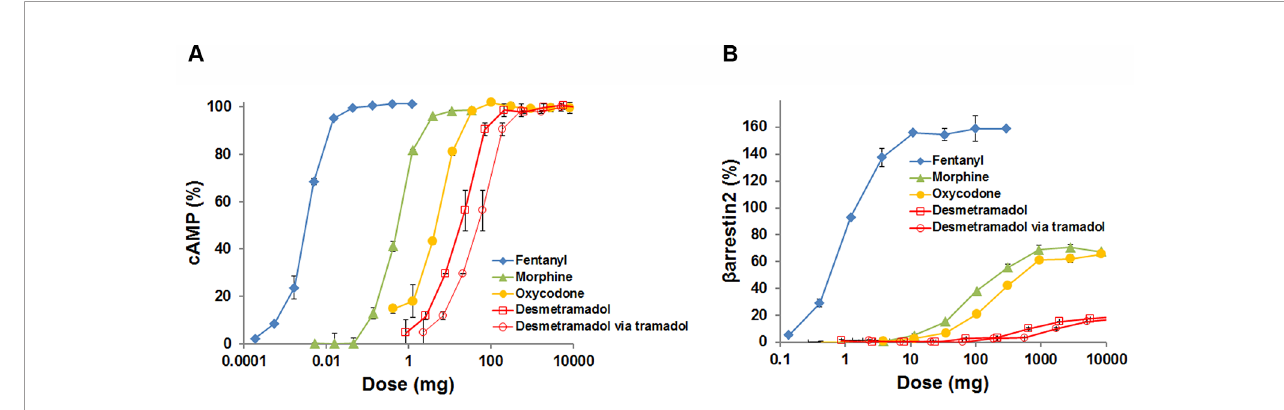
FIGURE 2 | G-protein modulated cAMP and b arrestin2 recruitment by the human MOR as a function of human dose. The adult human dose-to-maximum blood concentration (C max ) relationship for each opioid was used to model maximum cAMP accumulation and b arrestin2 recruitment as a function of human dose, where Dose = Reference Dose x (C tested /C max ) and the Reference Dose (mg) and C max (µM) are from Supplementary Table 1 and C tested (µM) is the tested agonist concentration. Data are means ± SD, displayed as percent of maximum [Met]-enkephalin ef fi cacy for assays run in duplicate. Data for doses >10 grams and > E max were censored for clinical irrelevance and to permit visualization of each curve, respectively. (A) Percent cAMP versus dose. (B) Percent b arrestin2 recruitment versus dose. Data for desmetramadol are shown for both direct dosing of desmetramadol and indirect dosing of desmetramadol via tramadol, its